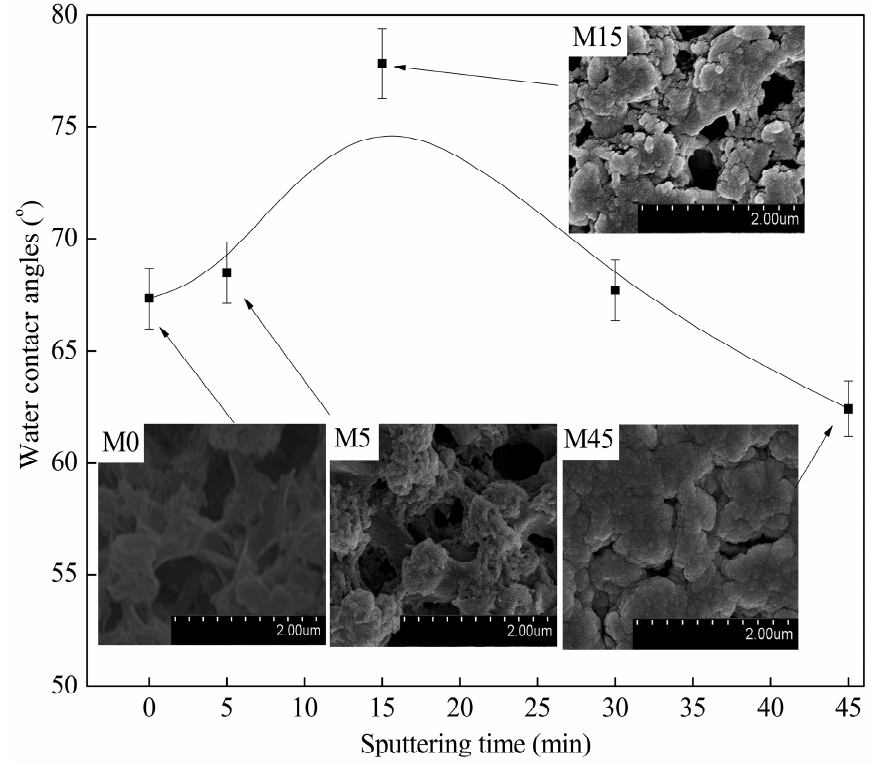
Figure 2. Water contact angles and surface FESEM images of the metalized membranes with different sputtering times.